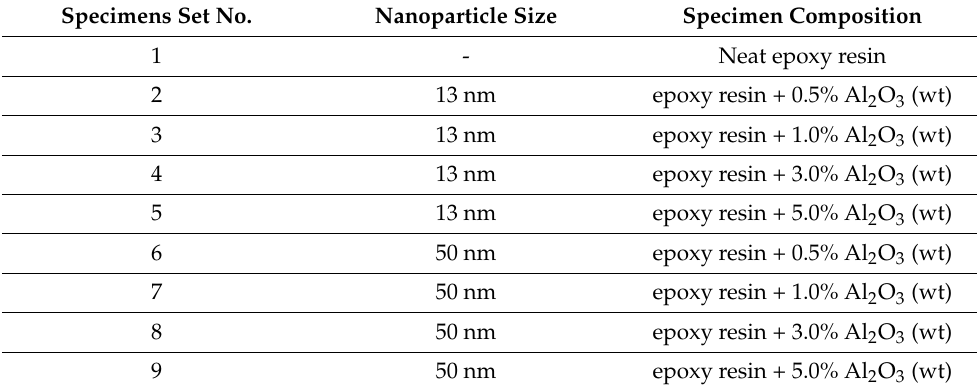
Table 2. Individual sets of the tested epoxy/alumina specimens. Specimens Set